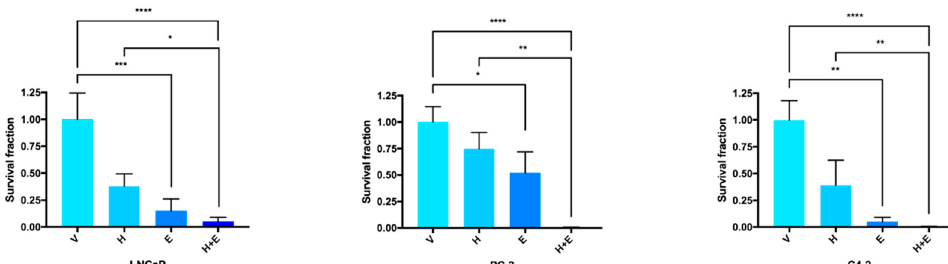
Figure 3. The combined treatment of hydralazine and enzalutamide reduced the colony formation ability in PCa (prostate cancer) cells. Values were normalized to the vehicle condition. (V—vehicle, H—hydralazine, E—enzalutamide, H+E—combination of hydralazine and